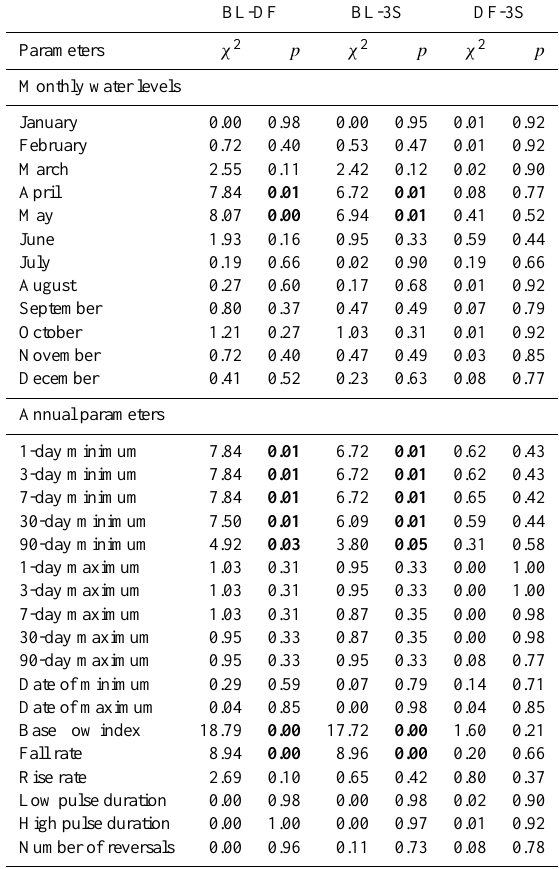
Table 2. Kruskal–Wallis test results for comparison of annual pa- rameters. Each column group represents a one-to-one comparison between the baseline (BL), definite future (DF) and 3S hydropower (3S) scenarios. χ 2 is the test statistic and p is the probability value of χ 2 . Significant p values ( ≤ 0.05) are highlighted in